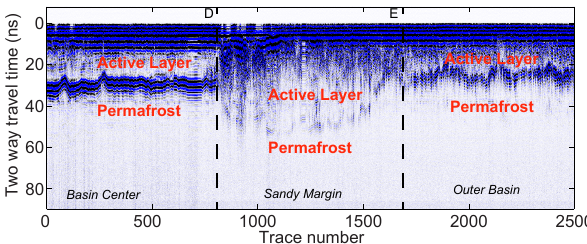
Fig. 7. A 500MHz dewowed radargram that crosses the three ge- ological units of our study. The horizontal extent of this profile is marked in Fig 6, which is approximately 200m and crosses mark- ers “D” and